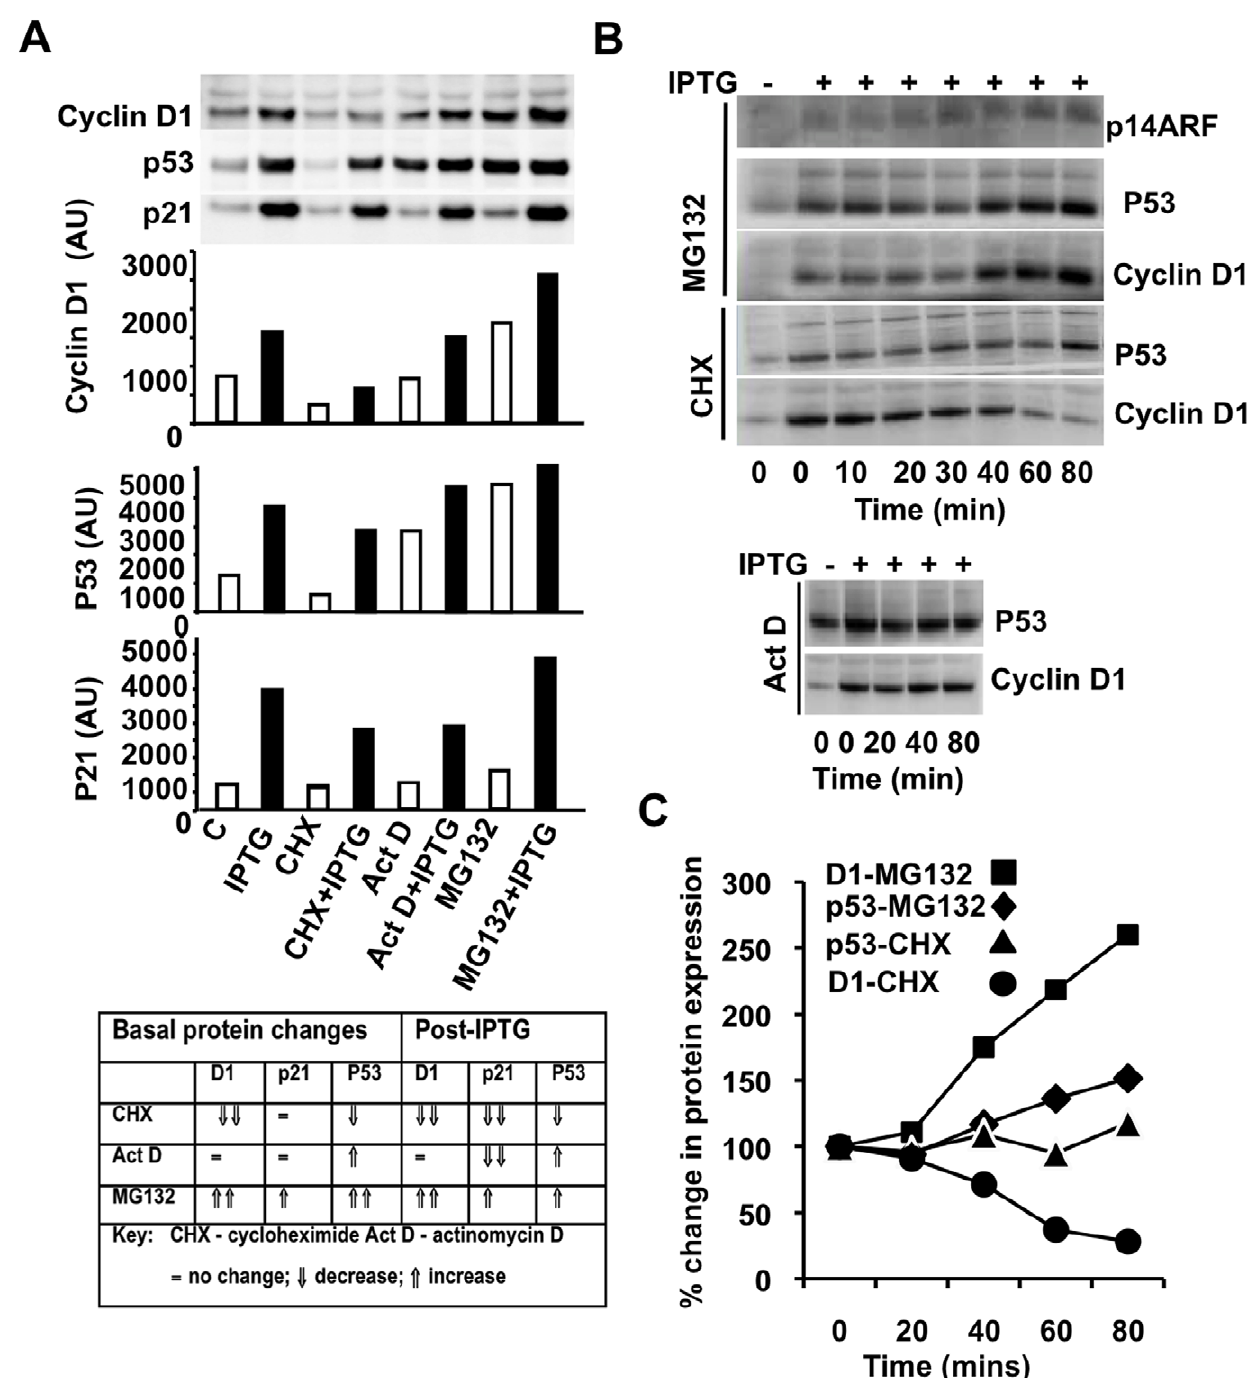
Figure 3. Comparative analysis of p14ARF transcriptional and post-transcriptional regulation of cyclin D1, p53 and p21 by p14ARF. MCF-7p14ARF 4a cells were treated with IPTG (lanes, 2, 4, 5, 8) or control (lanes 1, 3, 5, 7). Cells were subsequently treated with CHX, Act D, MG132 or vehicle (control). A. Cyclin D1, p21 and p53 protein expression was analysed by Western blot, post-treatments as indicated. Column graph: Protein expression was analysed by densitometry and expressed as arbitrary units (AU). B. Time course of p53, cyclin D1 expression in IPTG induced MCF- 7p14ARF cells with MG132, CHX and Act D. Representative Western blot from three experiments show relative protein expression of p14ARF, p53 and cyclin D1. C. Line graph of % change in cyclin D1 and p53 protein expression when compared to control post MG132 and CHX treatments. doi:10.1371/journal.pone.0042246.g003 to 80 min (Figure 3B and C). Cyclin D1 increased approximately expression (Figure 3B and C). Comparatively MG132 increased 2-fold within 50 min of MG132 treatment and decreased 2-fold p53 by increased , 50% of control at 50 min whereas CHX and Act D had little or no effect on p53 expression (Figure 3B). with CHX treatment whereas Act D had no effect on cyclin D1